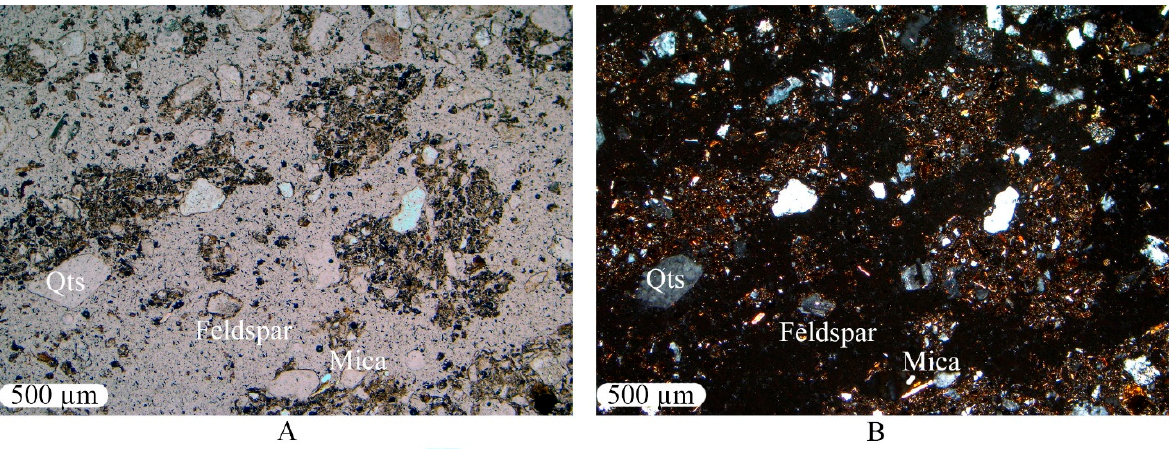
Figure 6. Micromorphological structure of the arable soil Y10 Ahp profile. ( A ) plane polarized light; ( B ) crossed polarized light.